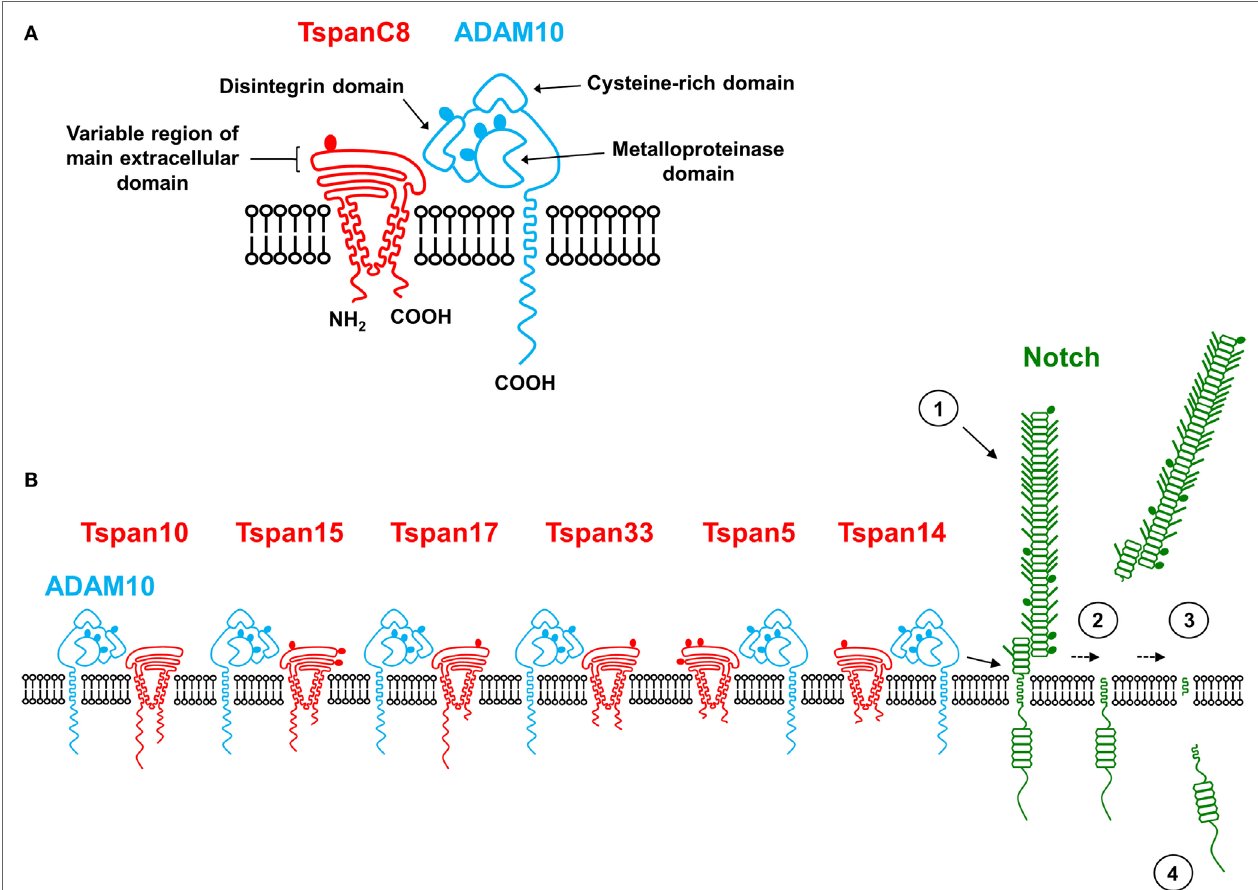
FigURe 1 | Six ADAM10 scissors: Tspan14 and Tspan5 may be important for Notch activation in immune cells. (A) A schematic representation of a TspanC8 and ADAM10. (B) A model figure to show the six different TspanC8/ADAM10 complexes, which have different subcellular localizations, distinct substrate specificities, and may have different ADAM10 conformations. Notch cleavage is initiated following engagement with a Notch ligand on another cell (1), which induces a conformational change that we hypothesize allows cleavage by a Tspan14/ADAM10 or Tspan5/ADAM10 scissor (2), followed by intramembrane cleavage by γ -secretase (3), to release the intracellular domain to act as a transcription factor and drive cell fate decisions (4). Tspan10 has also been implicated in Notch activation, but its relatively low expression by immune cells suggests no substantial role in these cells. N-linked and O-linked glycosylation sites are indicated by filled ovals and short lines,